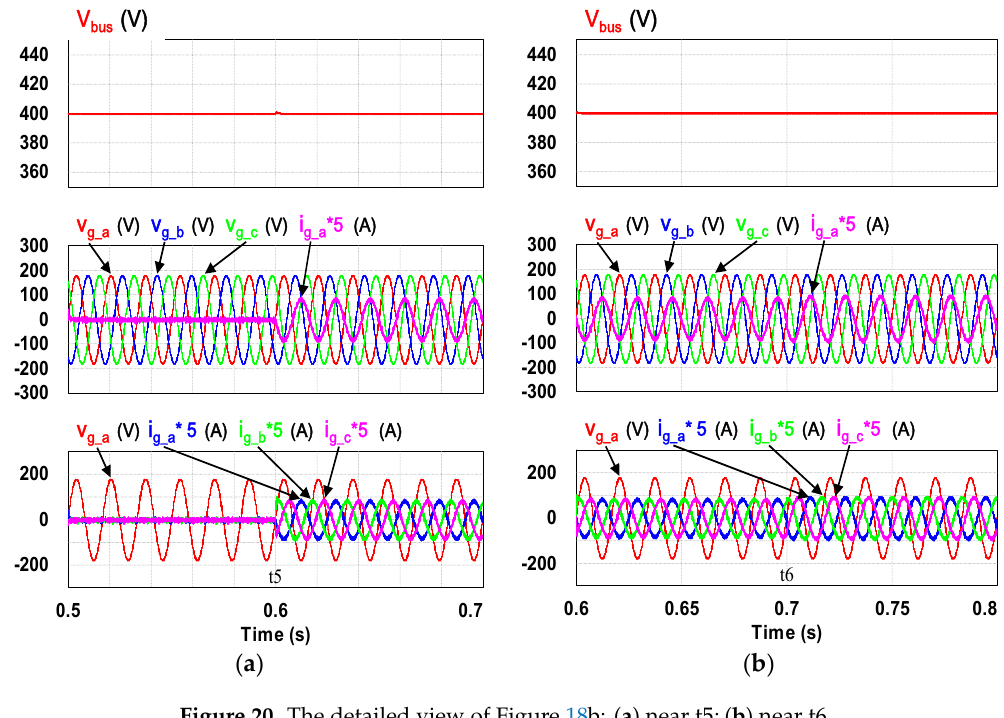
Figure 20. The detailed view of Figure 18b: ( a ) near t5; ( b ) near t6.